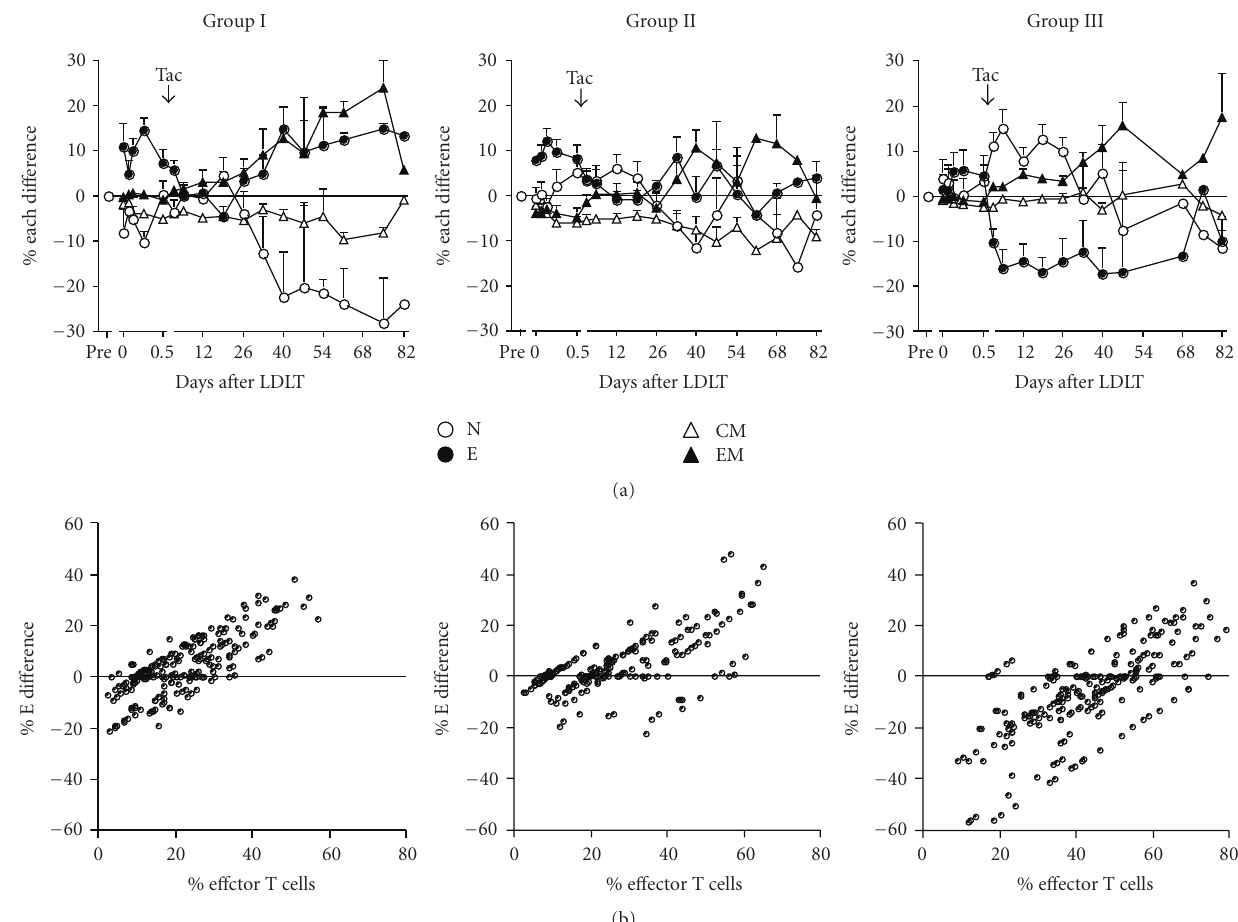
Figure 2: Changes in the % di ff erence of the CD8 + T cell subsets (a) and the scatter plot (b) after LDLT in 31 Group I, 33 Group II, and 28 Group III recipients. The % di ff erence was expressed by subtracting the proportion of CD8 + T cell subsets immediately before LDLT from the proportion at various times after LDLT. In the scatter plot, the deviation points of the % E di ff erence from pretransplant values were plotted as a function of the proportion of pre-existing CD8 + e ff ector T cells for each recipient. N, naive T cells; E, e ff ector T cells; CM, central memory T cells; EM, e ff ector memory T cells; Tac,